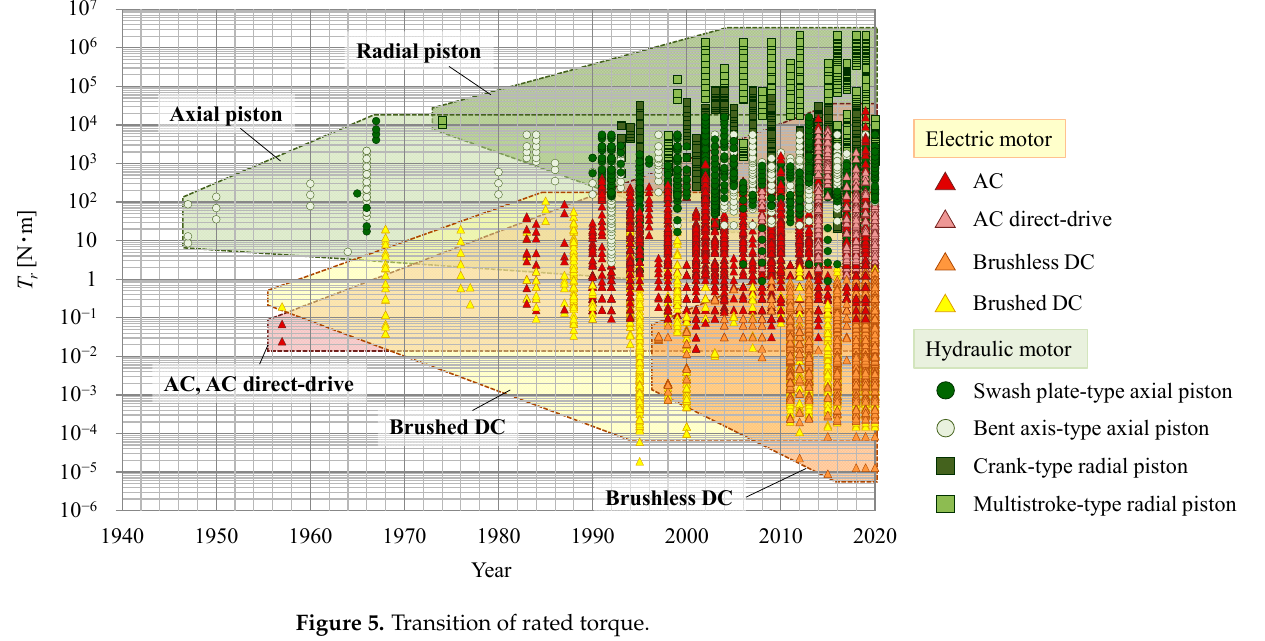
Figure 5. Transition of rated torque.